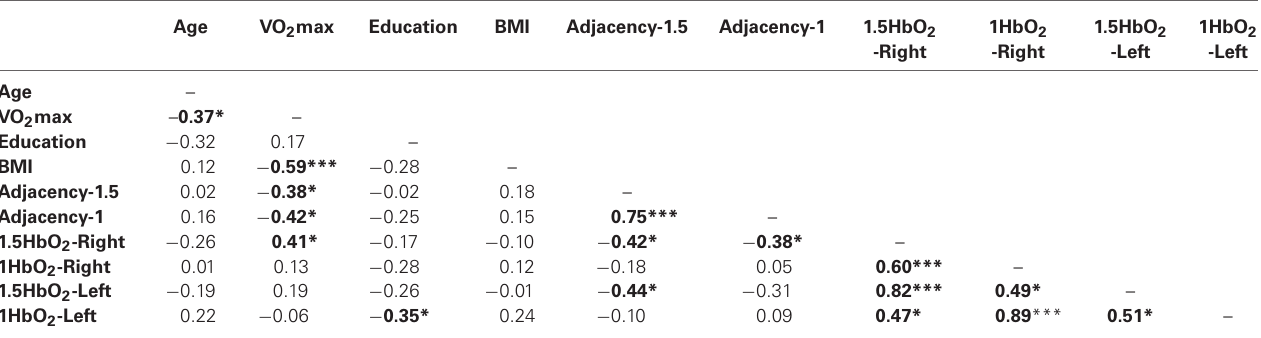
Note: BMI = Body Mass Index; Right = right dorsolateral prefrontal cortex; Left = left dorsolateral prefrontal cortex; 1.5 = RNG task at the pace of 1 number per